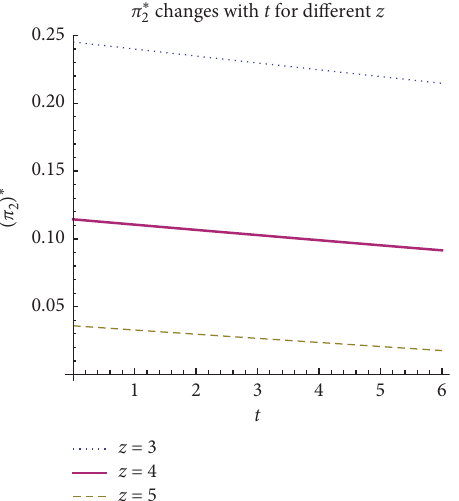
Figure 6: Values of π ∗ liability ratio z .